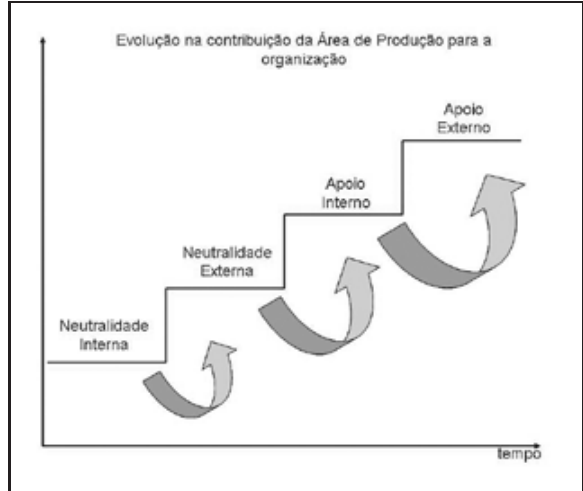
Figura 2 – Evolução na contribuição da área de